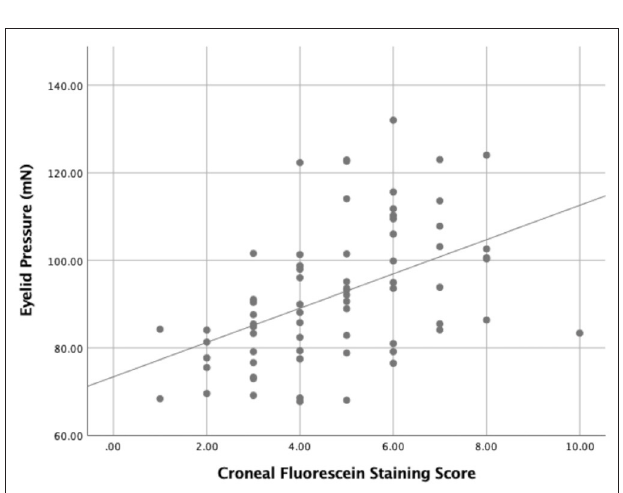
FIGURE 8 | The eyelid pressure of different levels of meibomain gland dropout (MGd). Statistical significance was assessed following comparison of the 3 levels (r = 0.226, P =